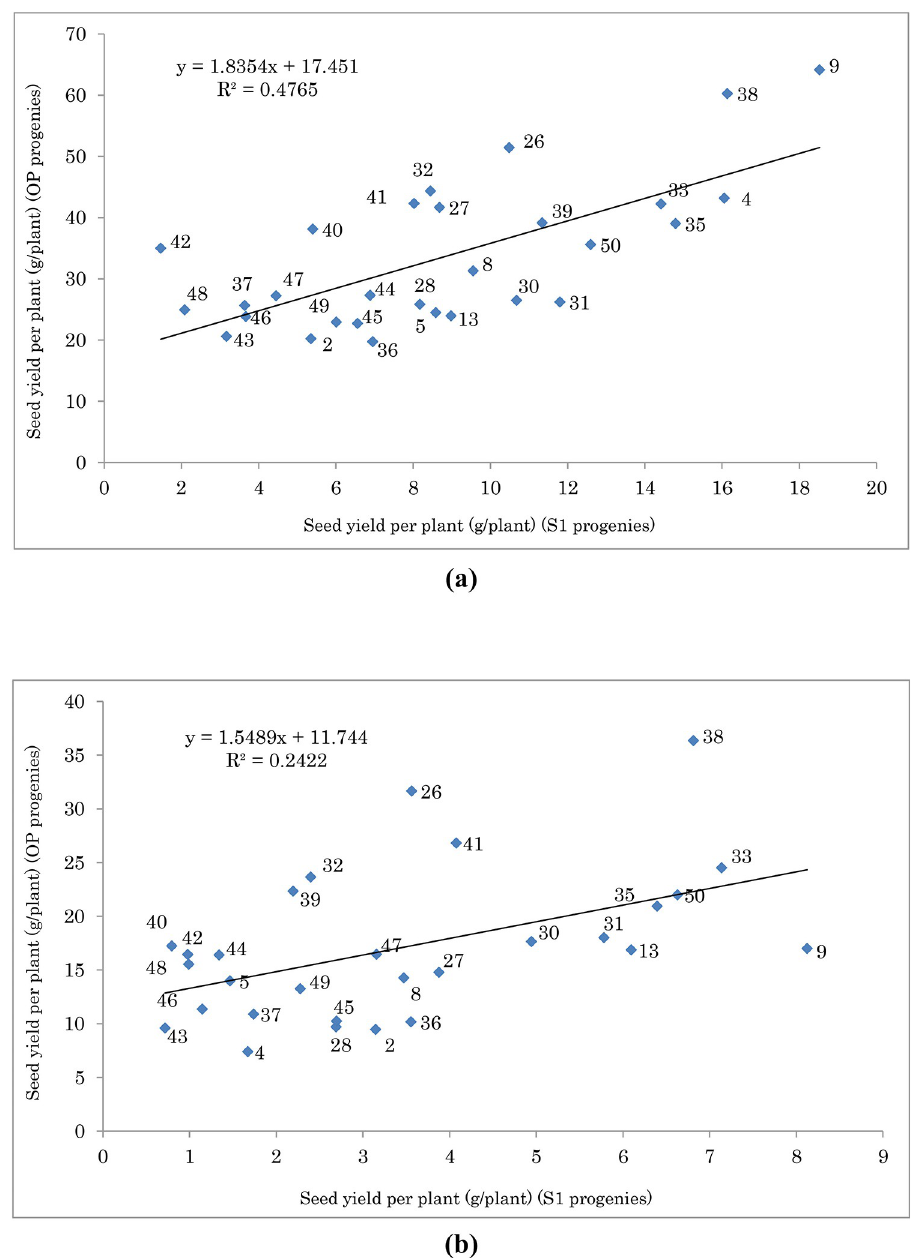
Fig 1. Seed yield per plant (SYP) of 29 selfed (S1) and open-pollinated (OP) populations of fennel under normal (a) and water deficit (b) conditions. The F-test indicated that the model is significant for normal condition in 0.01 probability level, and for water deficit condition is not